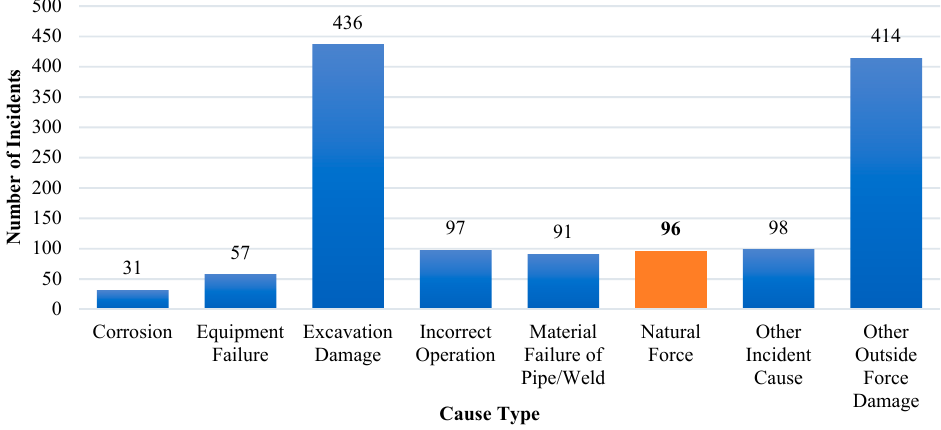
Figure 3. Number of natural gas incident causes based on PHMSA 20 year incident data.